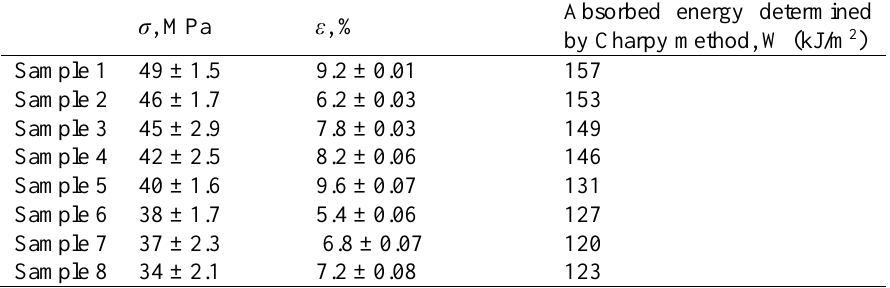
Table 2. Results of mechanical properties of obtained fire-retardant